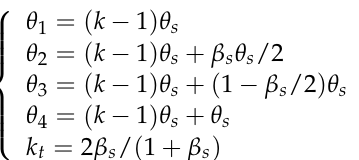
Figure 11. The MMF model of PMECC with slotted CR under on-load state.